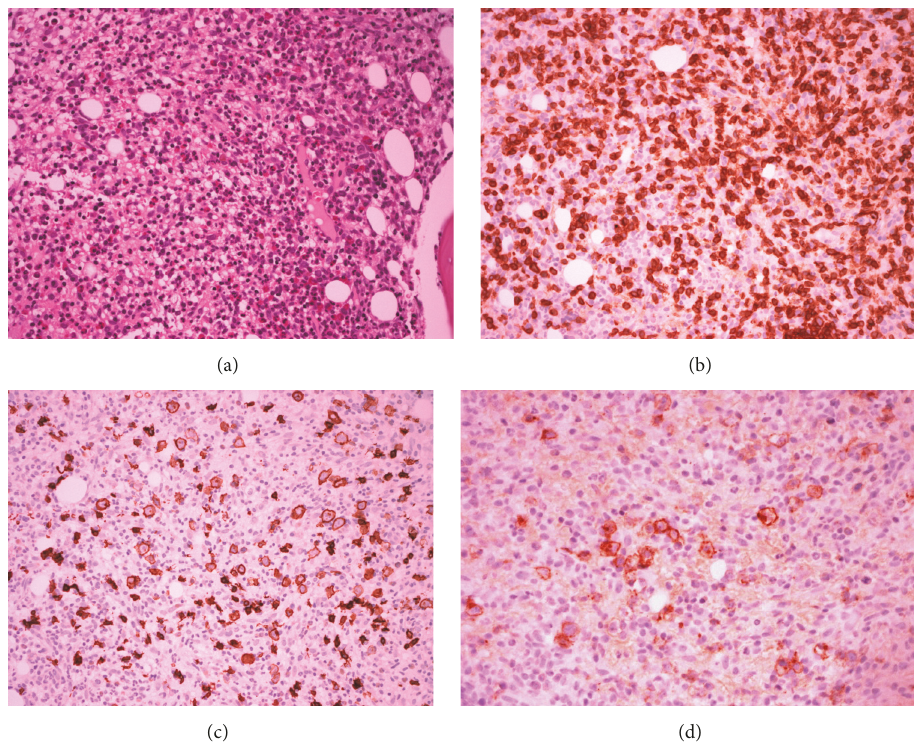
Figure 3: Histology and immunohistochemistry of bone marrow. (a) Hypercellular bone marrow with prominent lymphoid infiltration. (b) Atypical CD3-positive T-lymphocytes. (c) Enlarged pleomorphic cells with unilobated nuclei and prominent nucleoli, resembling RS-like B-cells. These cells show less pronounced expression of CD20 compared to normal B-lymphocytes (a CD20-positive small cell population in the background). (d) The RS-like B-cells are CD30-positive with characteristic paranuclear dot-like